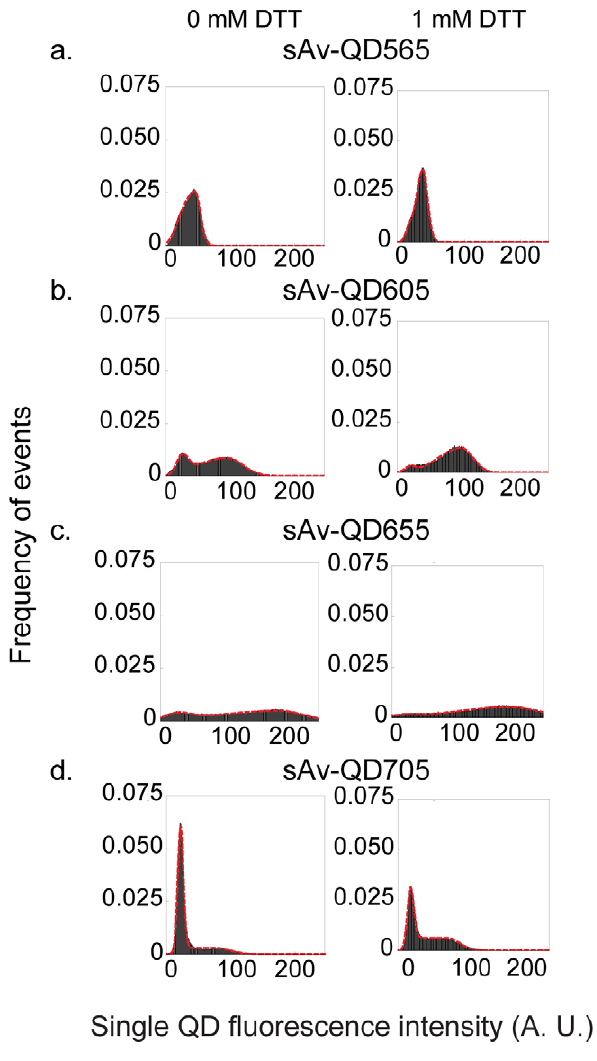
Figure 2. Cumulative frequency histograms of the background subtracted fluorescence intensities per pixel of 9 6 9 pixel arrays of identified single sAv-QD565, sAv-QD605, sAv-QD655, and sAv-QD705 in absence of DTT (left), and in presence of 1 mM DTT (right). These histograms were generated from 3 fields of view in total containing between , 100 # n # , 600 single QDs that were each imaged for m=300 image frames. The total sampling points for each histogram (m n) were , 30,000 # m n # , 180,000. The mean fluorescence intensities, I QDon , and fractional ‘‘on’’ time, F QDon , were determined by non-linear curve fitting (red dashed line) as described in the Methods section. The results for sAv-QD525, sAv-QD585, sAv- QD625, and AMP-QD800 are given in Fig. S1.